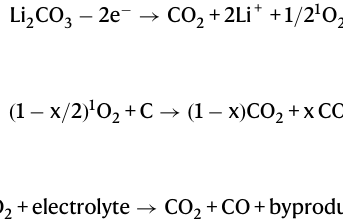
experiment with LiTFSI-based electrolytes, our results provide evi- dencethatLi 2 CO 3 decompositioninLiTFSI-tetraglymeelectrolytesis dominated by an electrochemical rather than chemical process.